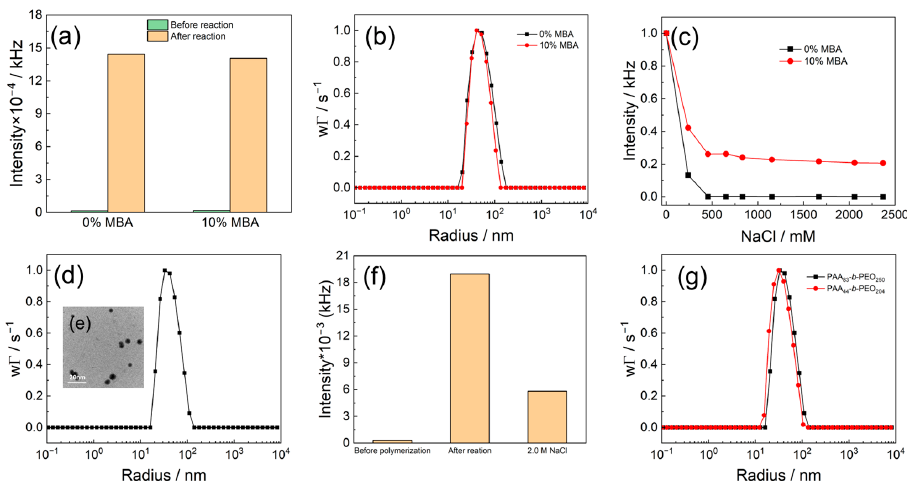
Figure 1. ( a ) Light scattering intensity of reaction solution prepared with and without 10% MBA cross-linkers in the presence of PAA 83 - b -PEO 250 template before and after UV light irradiation for 3 h. ( b ) Size distribution of reaction solution prepared with and without 10% MBA cross-linkers in the presence of PAA 83 - b -PEO 250 template after UV light irradiation for 3 h. ( c ) Light scattering intensity of formed polyion complex micelles prepared with PAA 83 - b -PEO 250 template titrated with sodium chloride. Size distribution ( d ) and TEM image ( e ) of PMETAC nanogel after removing PAA 83 - b -PEO 250 template. ( f ) Light scattering intensity of mixture before and after polymerization and the reaction mixture in 2.0 M NaCl, with PAA 44 - b -PEO 204 as the template. ( g ) Size distribution of PMETAC nanogel prepared with different template.